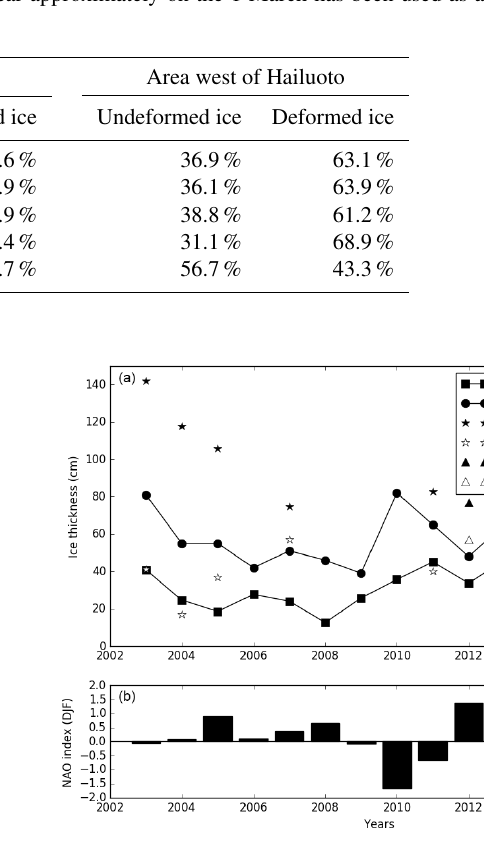
Figure 9. Time series of mean and modal ice thicknesses from Hailuoto drillings (circles) in the fast ice zone, ice charts (squares), helicopter EM surveys (black stars), and ship EM surveys (black triangles) in the drift ice area west of Hailuoto (a) . Helicopter EM modes (white stars) and ship EM modes (white triangles) were also observed over drift ice area west of Hailuoto. Panel (b) shows time series of mean NAO index of winter months DJF. Data from years 2003 to